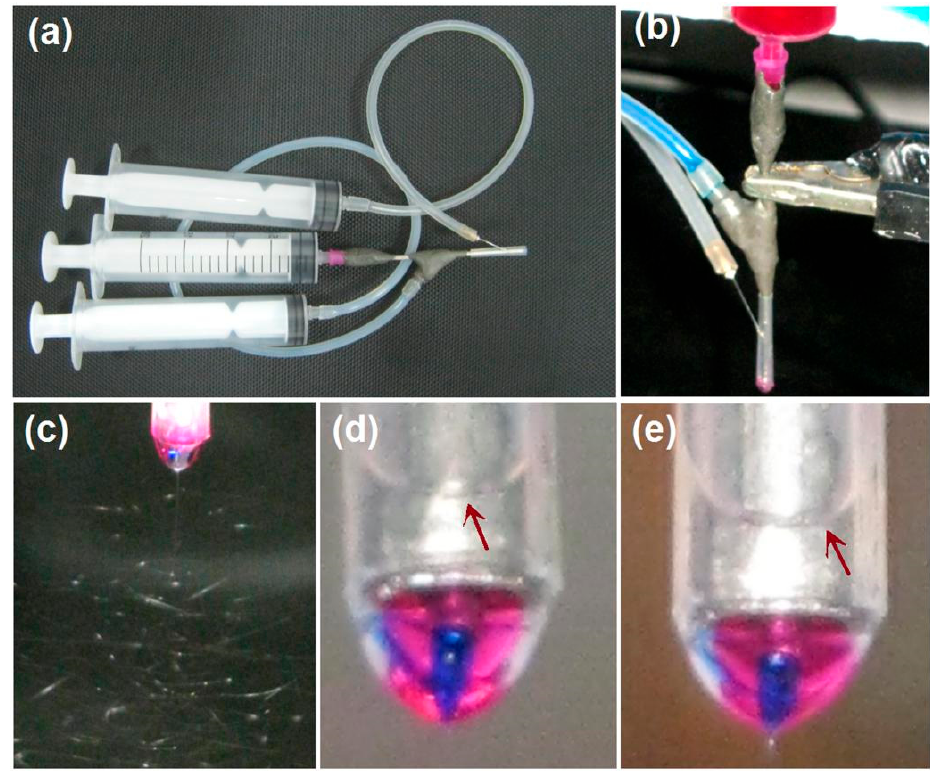
Figure 3. The implementations of the modified 3-axial electrospinning: ( a ) a digital photo of the linkages of three syringes with the three inlets of spinneret; ( b ) a digital photo exhibiting the pumping of three spinning solutions and the connection of a clip for transferring the electric energy from the power supply to the the spinning solutions; ( c ) a digital image showing the whipping and binding processes for preparing nanofibers F1; ( d , e ) the tri-layer complicated Taylor cones for preparing nanofibers F1 and F2, respectively. The red arrows indicate the sheath liquid arches.